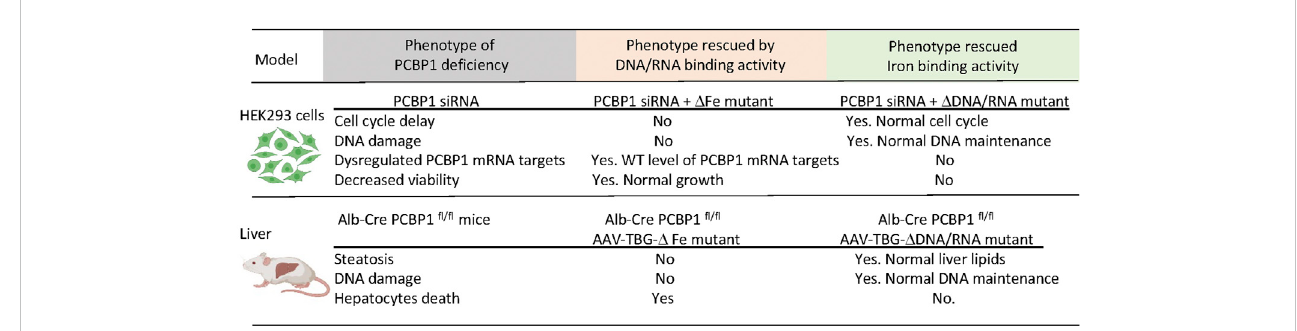
FIGURE 4 Dissection oftheironandDNA/RNA-bindingactivitiesofPCBP1.LossofPCBP1inculturedcellsandliversresultsinacomplexphenotypemanifestingas DNA damage and reduced cell viability. PCBP1 protein contains three K homology (KH) domains. Mutations in iron-binding residues of KH1 (D82A), KH2 (E168A), and KH3 (E350A) block iron coordination by PCBP1. The Δ Fe mutant with these substitutions cannot bind iron but preserves binding to DNA/RNA oligonucleotides. Mutations in nucleic acid-binding residues in KH1 (R40A), KH2 (R124A), KH3 (R306A) disrupt binding to single-stranded nucleic acids. Withthesesubstitutions,the Δ DNA/RNAmutantcanbindironbutnotDNAorRNA.HEK293stablecelllinesexpressingPCBP1variantsweretreatedwithsiRNA targeting 3 ′ UTR to deplete endogenous PCBP1. Mice with liver-speci fi c deletion of PCBP1 were transduced with AAV expressing PCBP1 variants from the hepatocyte-speci fi cTBGpromoter.ExpressionofmutantvariantsofPCBP1withthelossofiron-orDNA/RNA-bindingactivitycomplementedonlypartofthe deletion